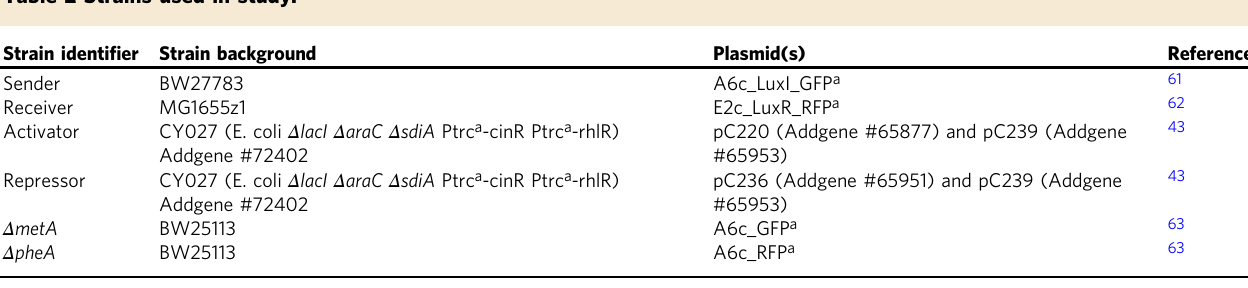
Table 2 Strains used in study.